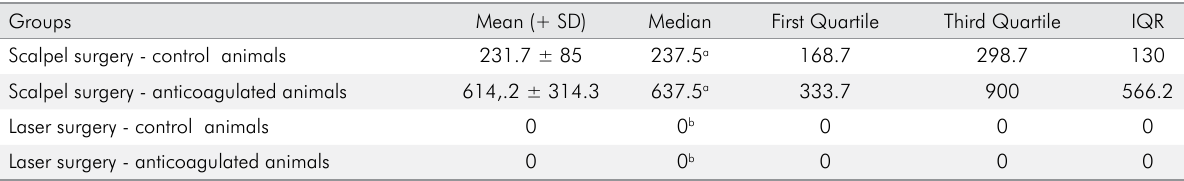
The same letters indicate absence of statistical differences (p ≥